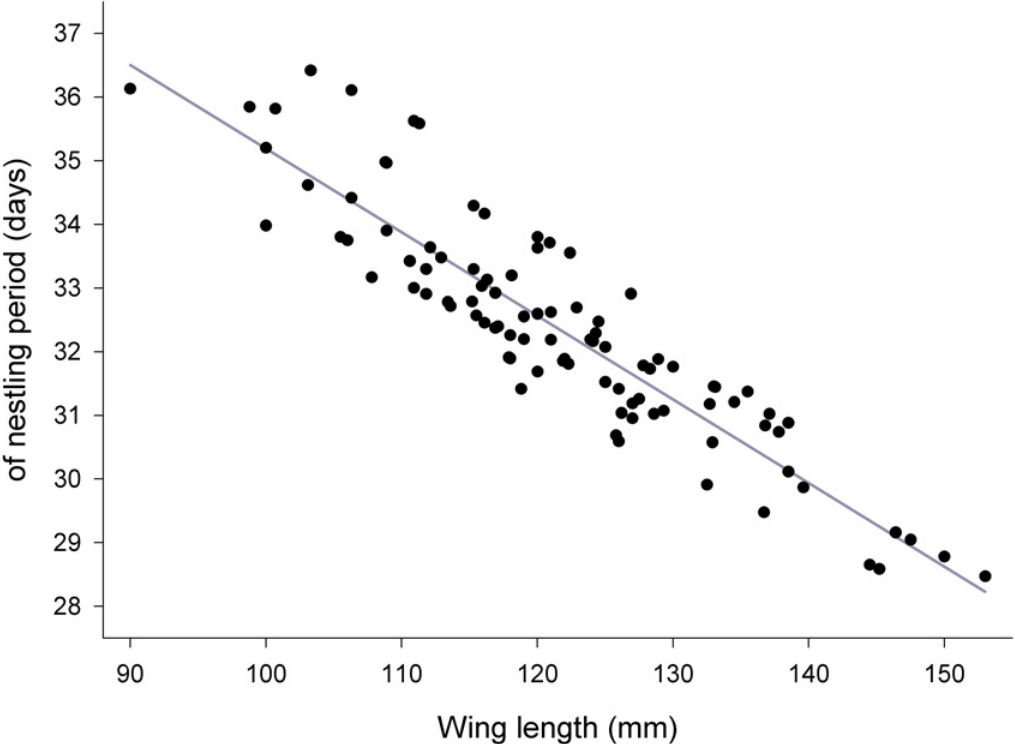
Fig 1. Predicted values of the individual duration of nestling period plotted against the nestlings ’ wing length extrapolated to the age of 30 days from